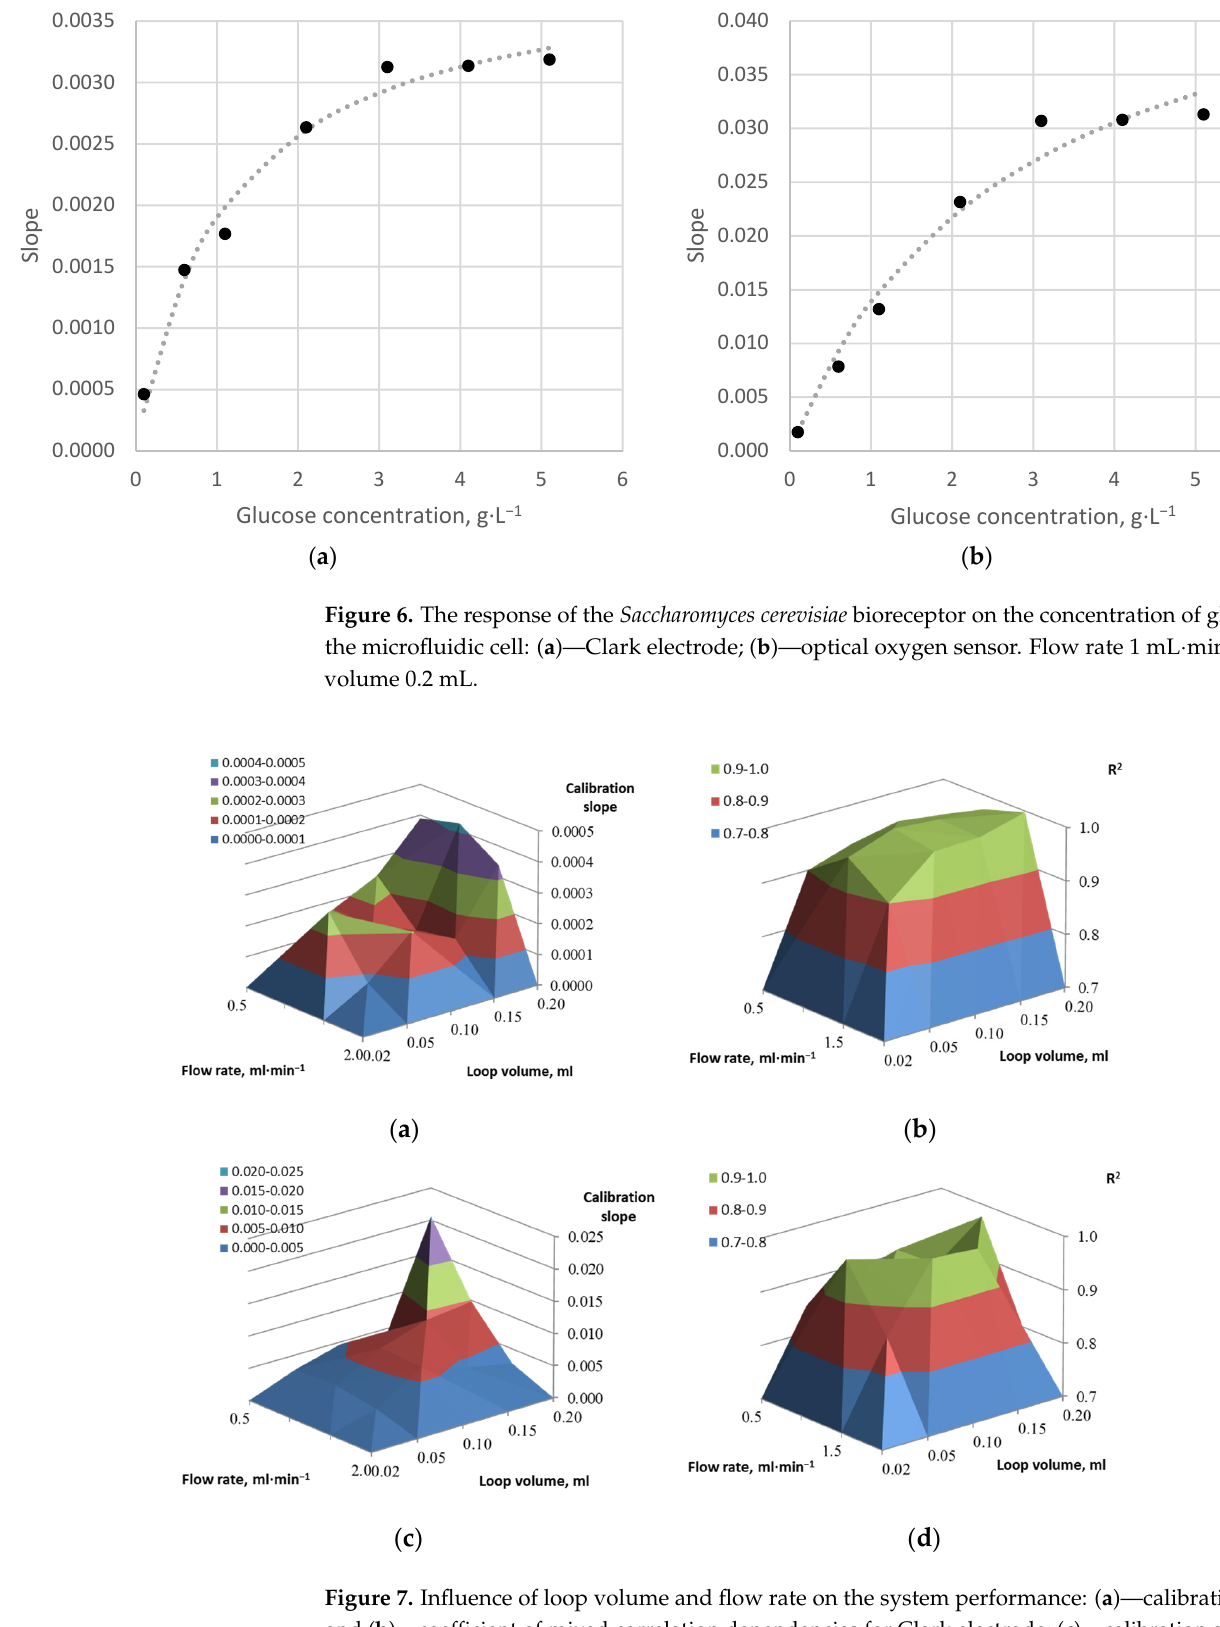
Figure 6. The response of the Saccharomyces cerevisiae bioreceptor on the concentration of glucose in the microfluidic cell: ( a )—Clark electrode; ( b )—optical oxygen sensor. Flow rate 1 mL·min − 1 , loop volume 0.2 mL.